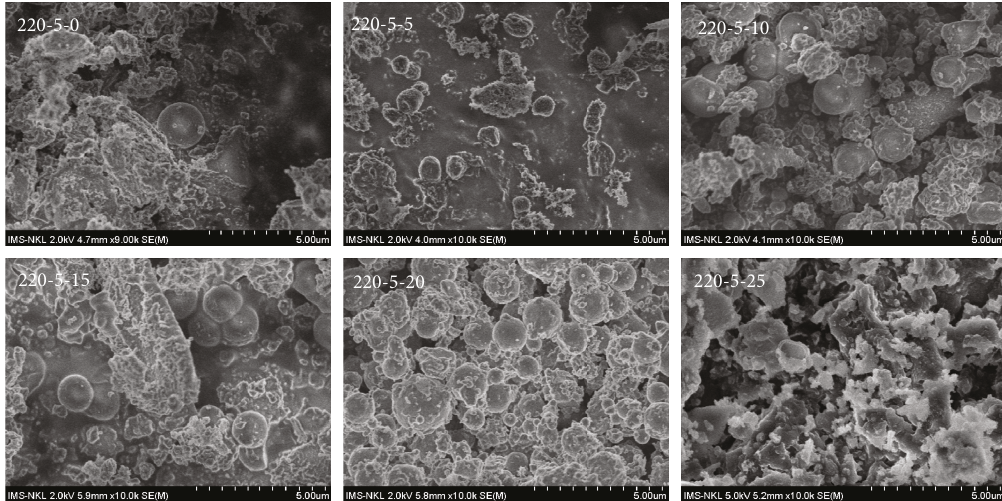
Figure 4: SEM images of hydrochars at different catalyst/feedstock